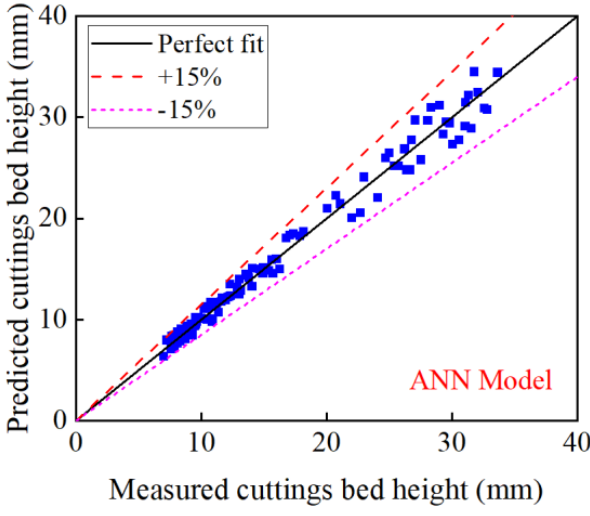
Figure 6. Measured cuttings bed height and predicted cuttings bed height with the ANN model.